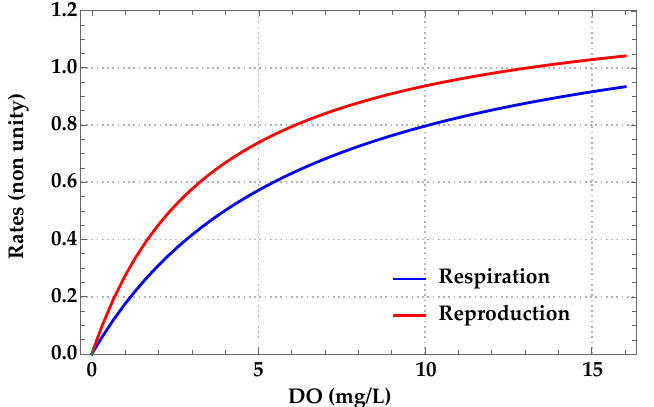
Figure A1. Impacts of hypoxia on reproduction and respiration of aquatic invertebrates. Data digitized at different oxygen concentrations, scaled to control conditions (normoxia) and the Michaelis–Menten model fit (±95% CI). Adapted from Galic et al.